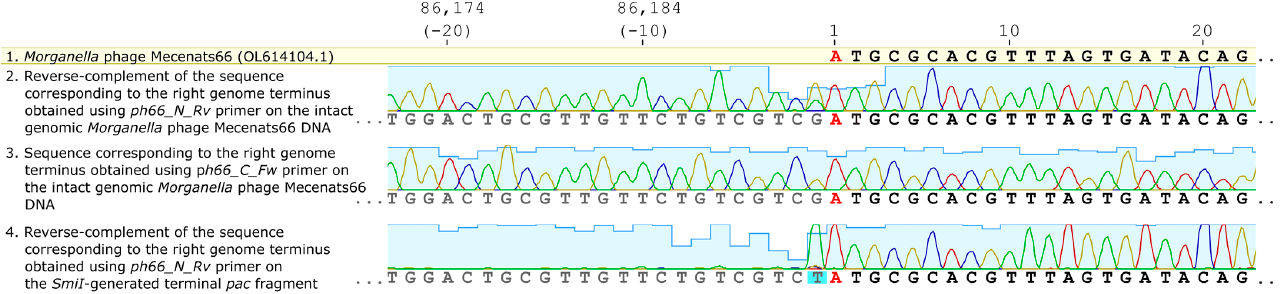
Figure 6. The Morganella phage Mecenats66 exact genome termini verification. The first track shows the rightward terminus nucleotide sequence of the Mecenats66 genome (first 22 bases). Tracks 2, 3, and 4 show Sanger-based sequencing read chromatograms corresponding to both termini, peaks are colored based on the base-call (red—adenine, green—thymine, yellow—guanine, blue—cytosine) and their heights represent the relative signal intensities. Cyan bars in the background represent the relative quality of the called base. In all of the tracks, the first base in the genome of Mecenats66 corresponding to an adenine is marked in red. In track 4, the thymine base with a cyan background (an adenine in the non-reverse-complemented original read) represents a non-template single base overhang added after the physical end of the most sequenced pac site-containing